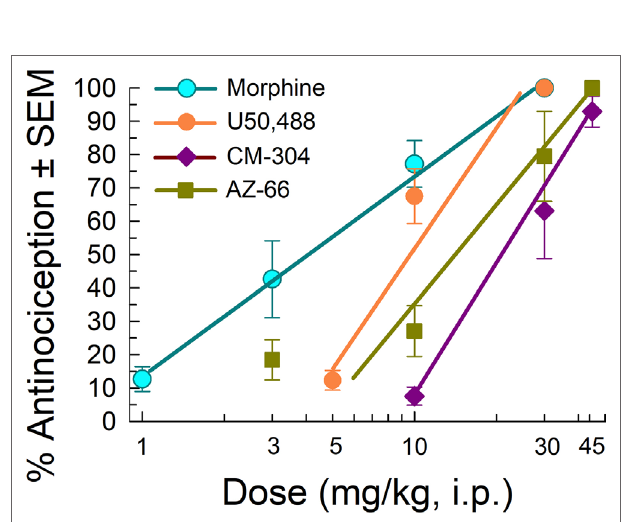
FIGURE 7 | Testing efficacy against acute thermal nociception in the 55°C warm-water tail-withdrawal test. Opioid agonists morphine and U50,488 are shown as positive controls. Morphine and U50,488 points represent average response ± SEM at peak effect, 30 min after admin in eight or 16 mice. All points with CM-304 and AZ-66 represent average response ± SEM at peak effect, 20 min after admin in eight mice/dose tested.